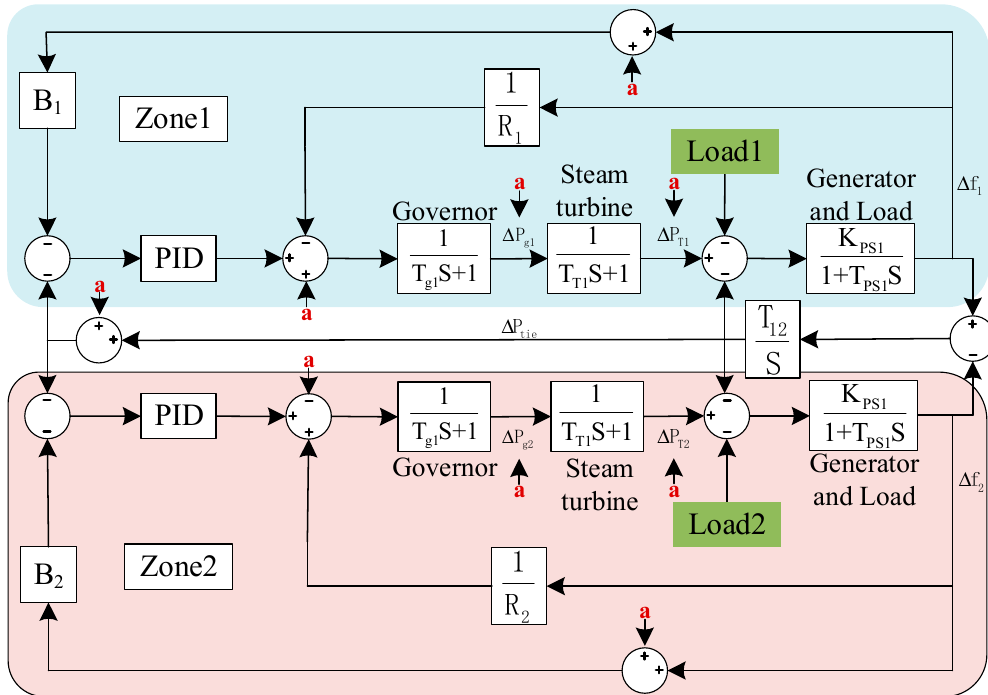
Figure 2. Mathematical Model of Two-area Power System.